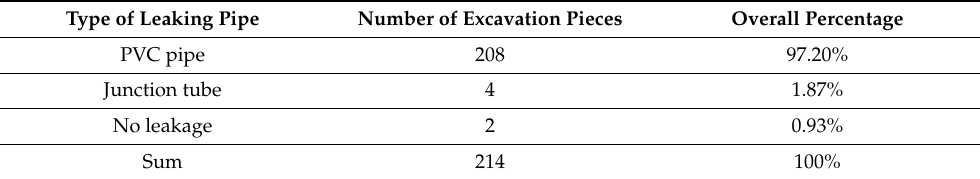
Table 1. Localized AI water leakage diagnostic instrument excavation verification: leaking pipe category statistics.